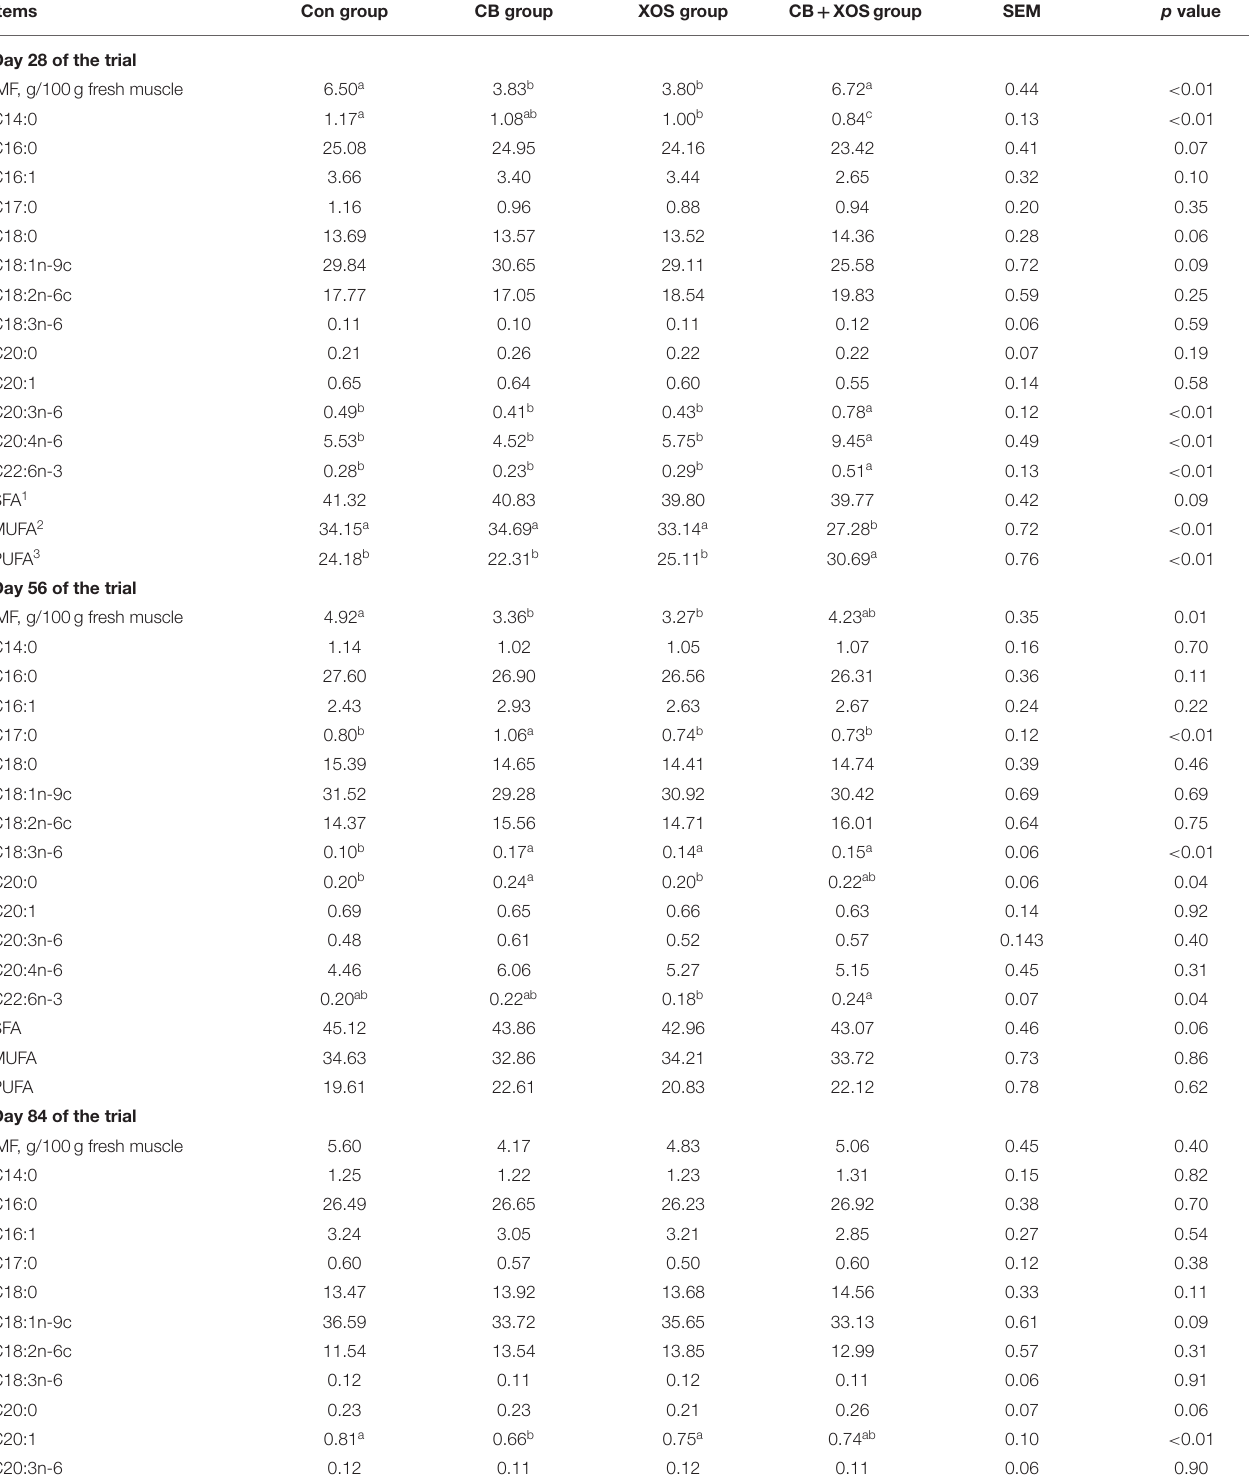
TABLE 6 | Effects of dietary addition with CB and XOS on intramuscular fat (IMF) content and fatty acid composition of longissimus dorsi muscle of Huanjiang mini-pigs (% total fatty